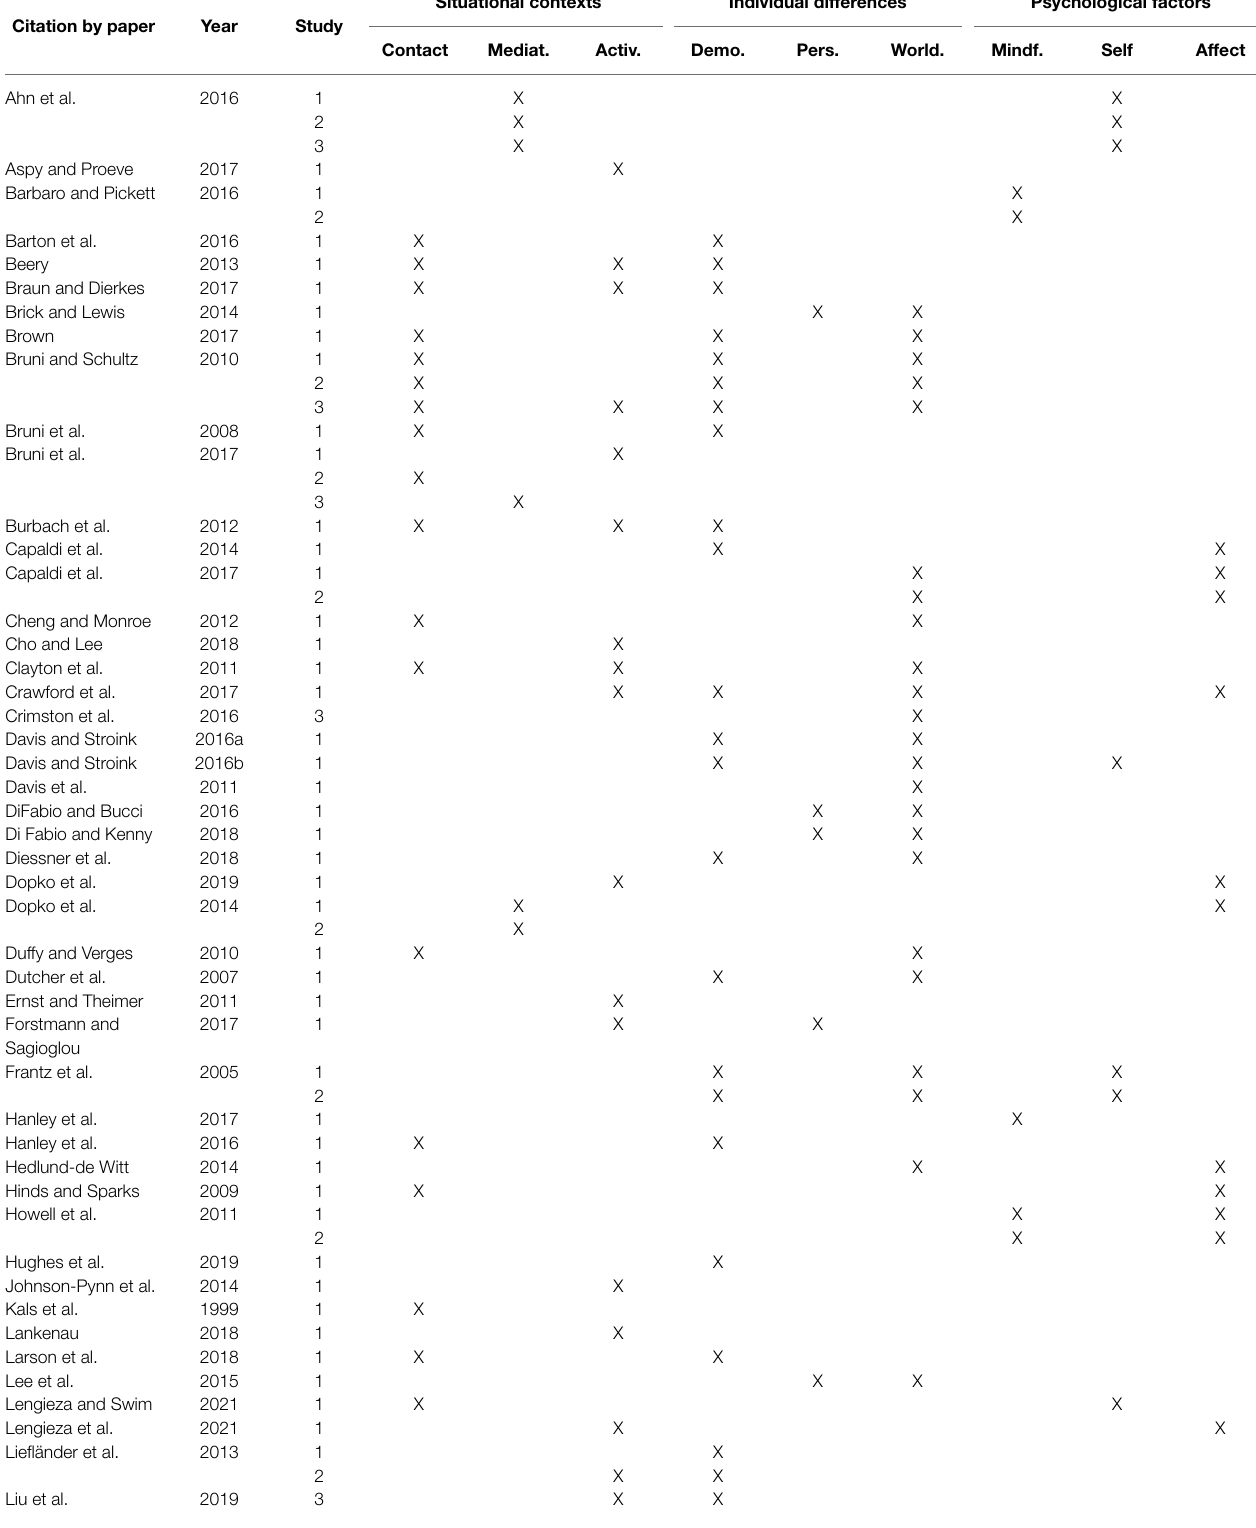
TABLE 1 | Sources included in the review and the location of their